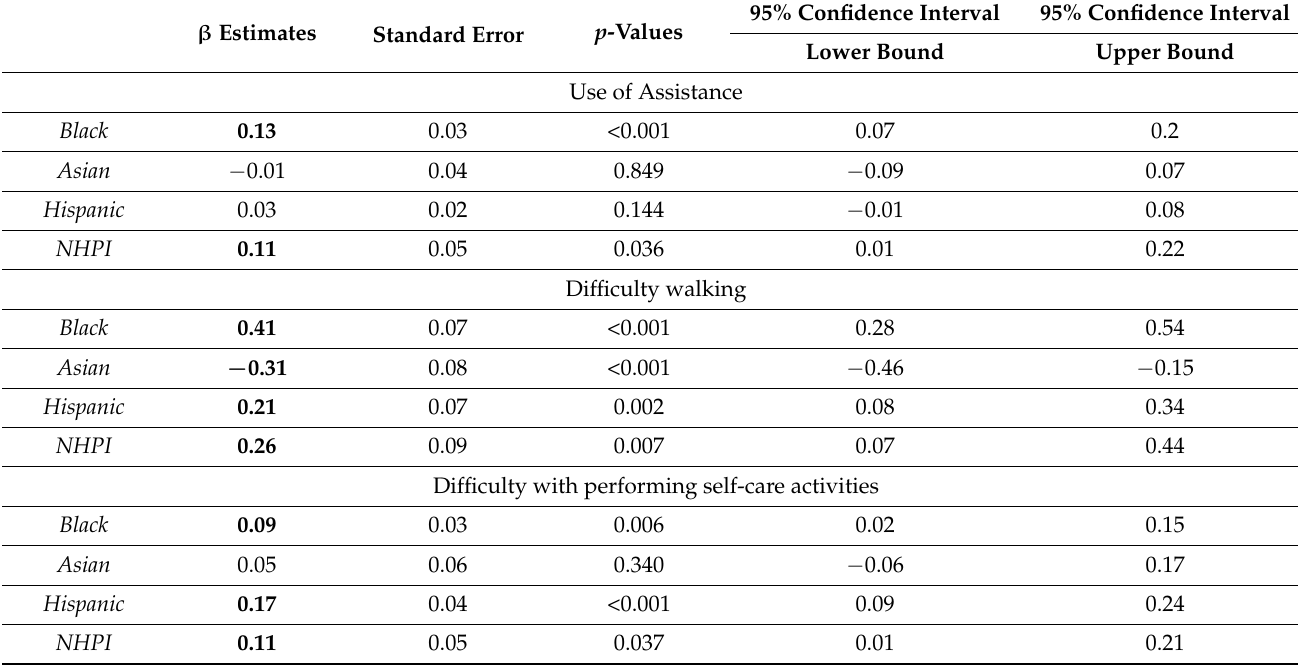
Table 3. Associations between Functional Limitations and